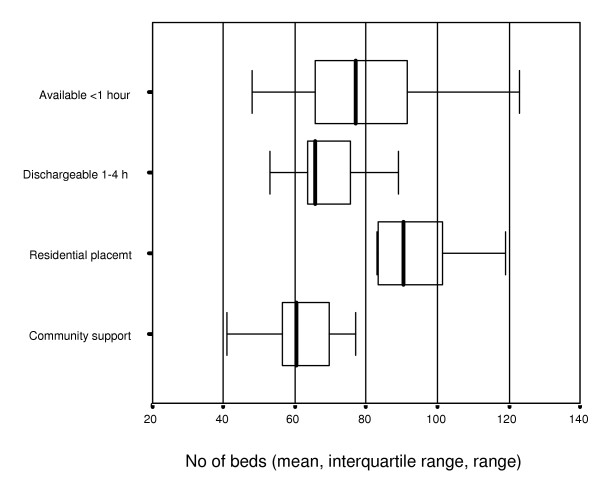
Numbers of available beds.